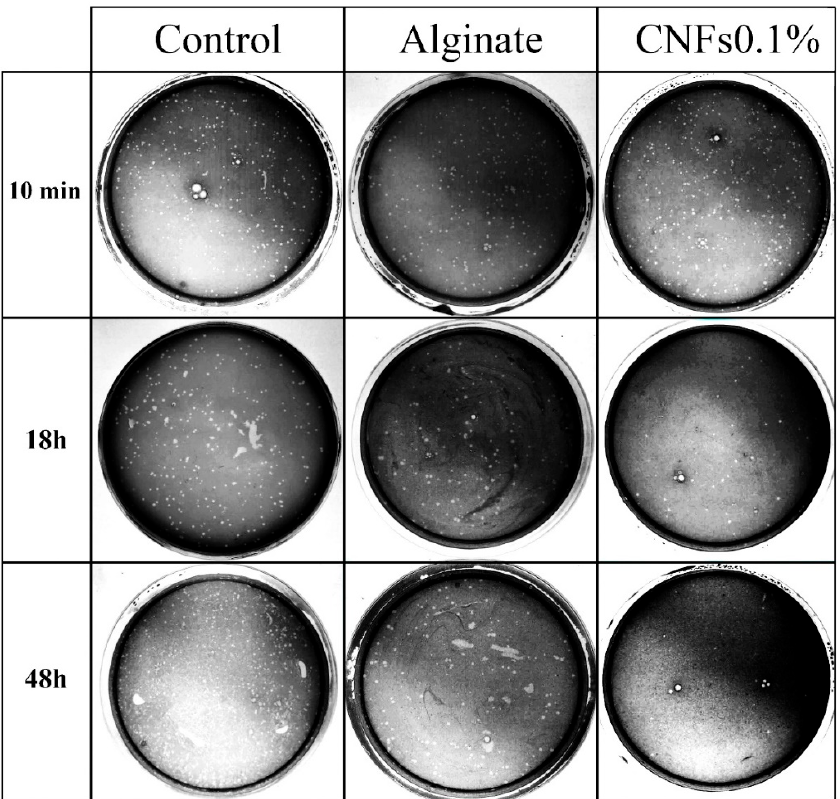
Figure 3. Representative titration plaques of bacteriophage T4: antiviral tests of alginate films and alginate/carbon nanofibers films (CNFs0.1%) at 10 min, and 18 and 48 h of contact with the virus.